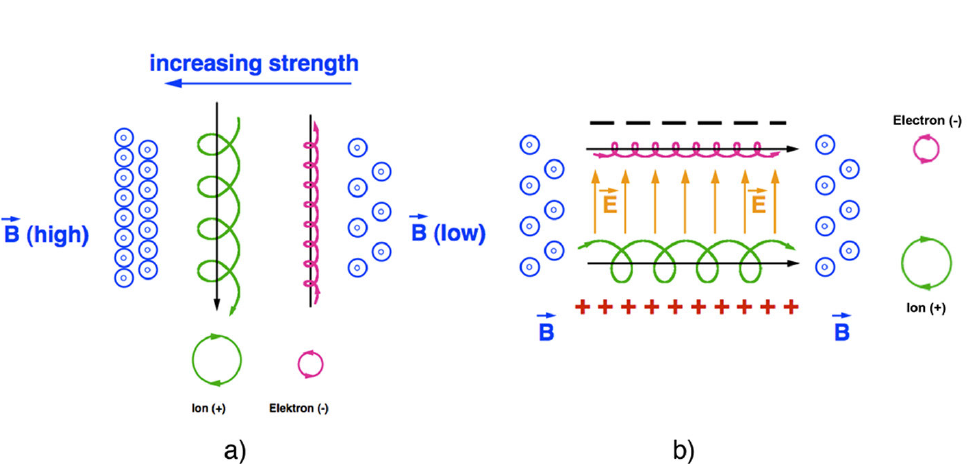
Fig. 6. – Illustration of the effect of the inhomogeneity of the toroidal magnetic field on plasma confinement. The effect can be easily explained in two steps considering the formula for the . For the first step see panel (a) on the left: formation of the electric Larmor radius: ρ = mv ⊥ qB field due to the inhomogeneity of the toroidal field. The figure shows a cross-section of the plasma; the orbits of ions and electrons are no longer perfectly circular, but the particles spiral vertically up and down: indeed from the formula follows that ρ decreases as B increases and increases as B decreases. As ions and electrons rotate in opposite directions, they move vertically in opposite directions, creating an electric field in the plasma. Second step, see panel (b) on the right: effect of the created electric field on the plasma particles. We consider a small section of the previous figure, such that B is to a good approximation homogeneous over the section, and thus the effect of E alone can be studied. As B is constant over this section, the only parameter influencing the movement of the particles is the velocity. Positive ions are accelerated towards the negative layer of charges and decelerated towards the positive layer of charges, leading to an increase, respectively, decrease of the velocity of the particle. From the formula follows that with increasing velocity the Larmor radius increases and decreases with decreasing velocity: thus the particle spirals vertically outwards. A similar reasoning for the electrons leads to exactly the same result. Both electrons and ions move thus horizontally outward: the plasma is unstable. To solve this problem, the formation of the electric field has thus to be avoided. Adding a poloidal component to the toroidal field is a way to do